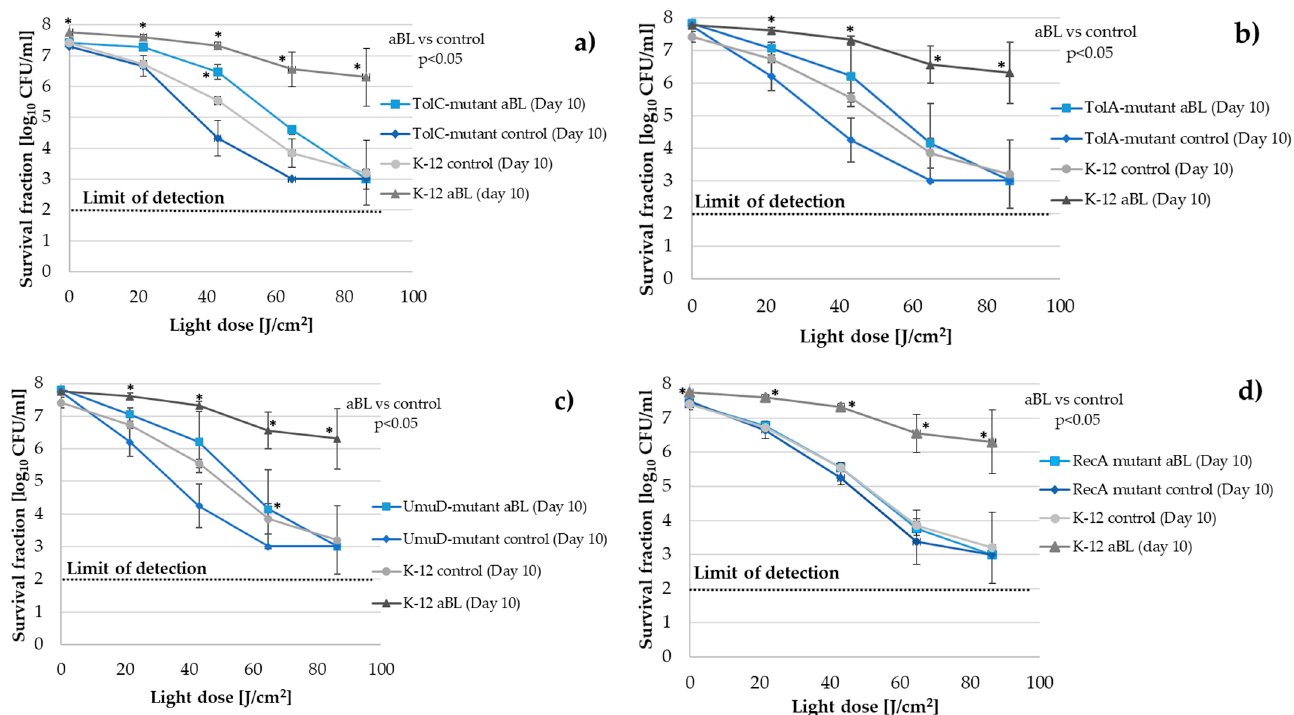
Figure 5. E. coli K-12 tolC -, tolA -, umuD -, and recA- deficient mutant responses to sublethal aBL treatment. The tolC -, tolA -, umuD -, and recA -deficient mutants were subjected to multiple sublethal exposures of aBL under conditions that were identical to those that were applied to the wild-type E. coli K-12 strain. ( a ) The tolC -deficient mutant developed weaker tolerance to aBL than the wild-type strain, similarly to the tolA - ( b ) and umuD -deficient mutant ( c ); ( d ) The lack of a RecA protein prevented the development of tolerance to aBL. * All of the significant differences were estimated in comparison to the control from each day.